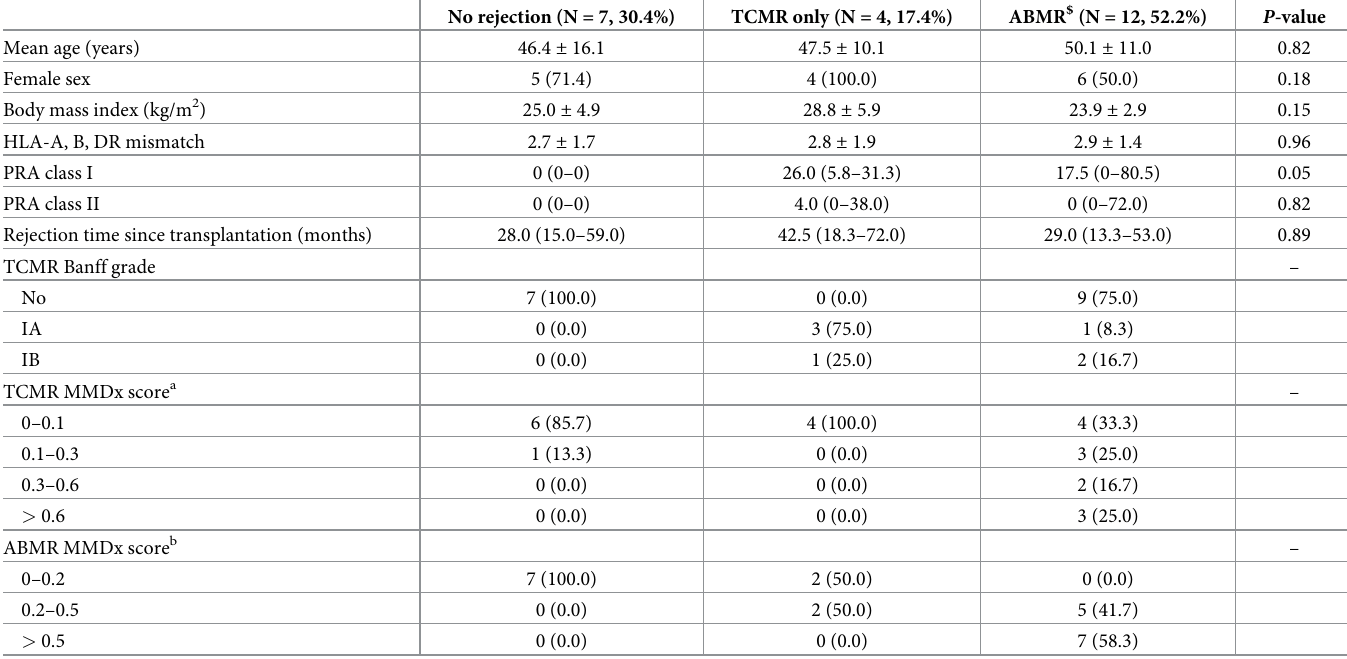
pure TCMR had a median rejection time of 42.5 months and showed a low correlation with MMDx results. Considering that the results of the ABMR were highly consistent between his- tologic and molecular diagnosis, this disagreement in TCMR is not likely a result of an error Table 6. Baseline and clinical characteristics of the patients in the molecular diagnosis